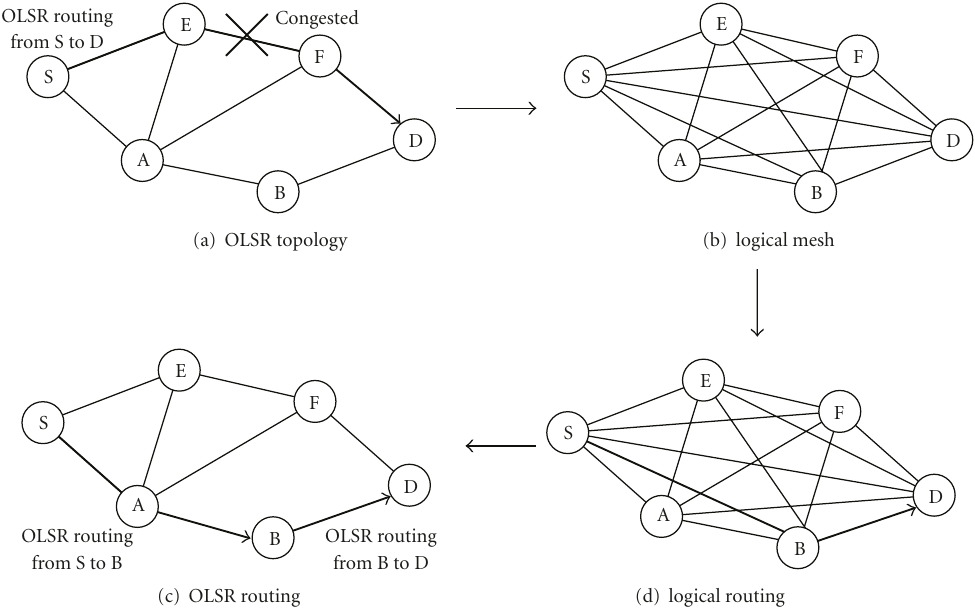
Figure 1: QoS-aware routing by proposed mechanism.